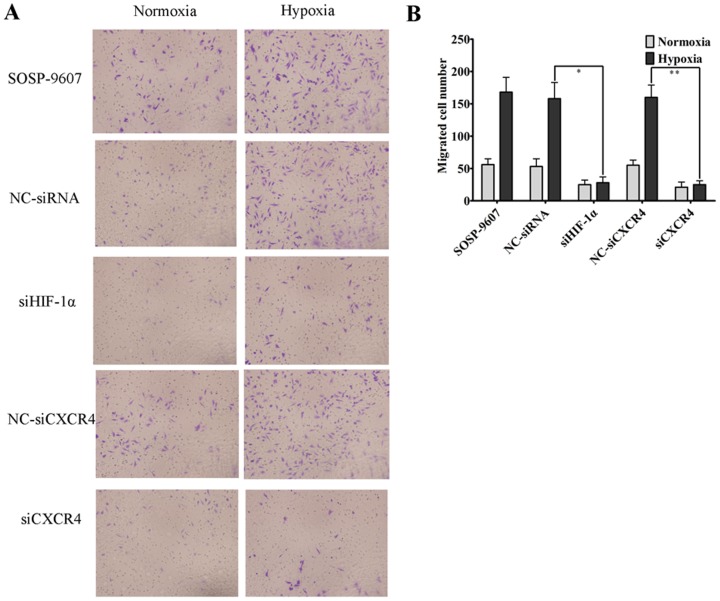
Hypoxia enhances SOSP-9607 cell migration in vitro.Human SOSP-9607 OS cells were exposed to either hypoxia or normoxia. Cell migration was assessed as described in the Methods. A. Representative photographs of migrated SOSP-9607 cells on the membrane at a magnification of 100×. B. Data are presented as the means ± SDs of duplicate samples and are representative of three independent experiments. * p<0.05, ** p<0.05.